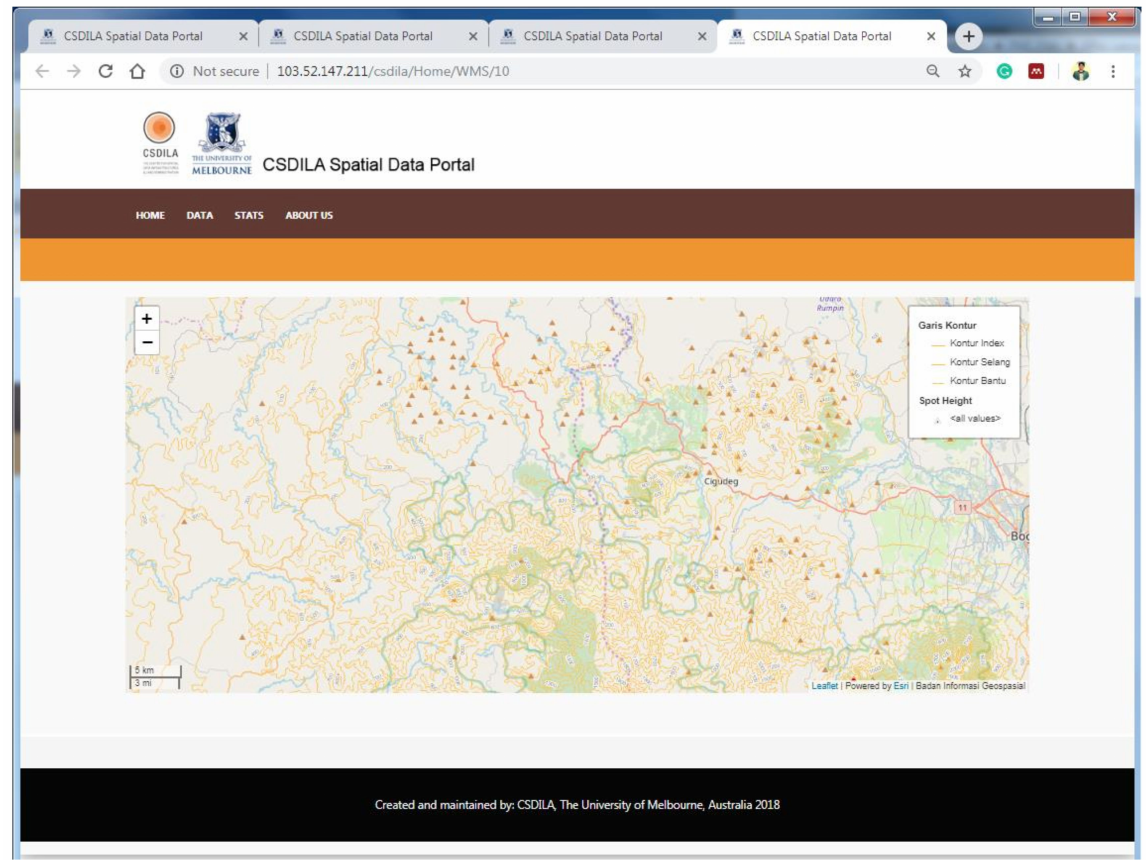
Figure 10. Web map service page (Map